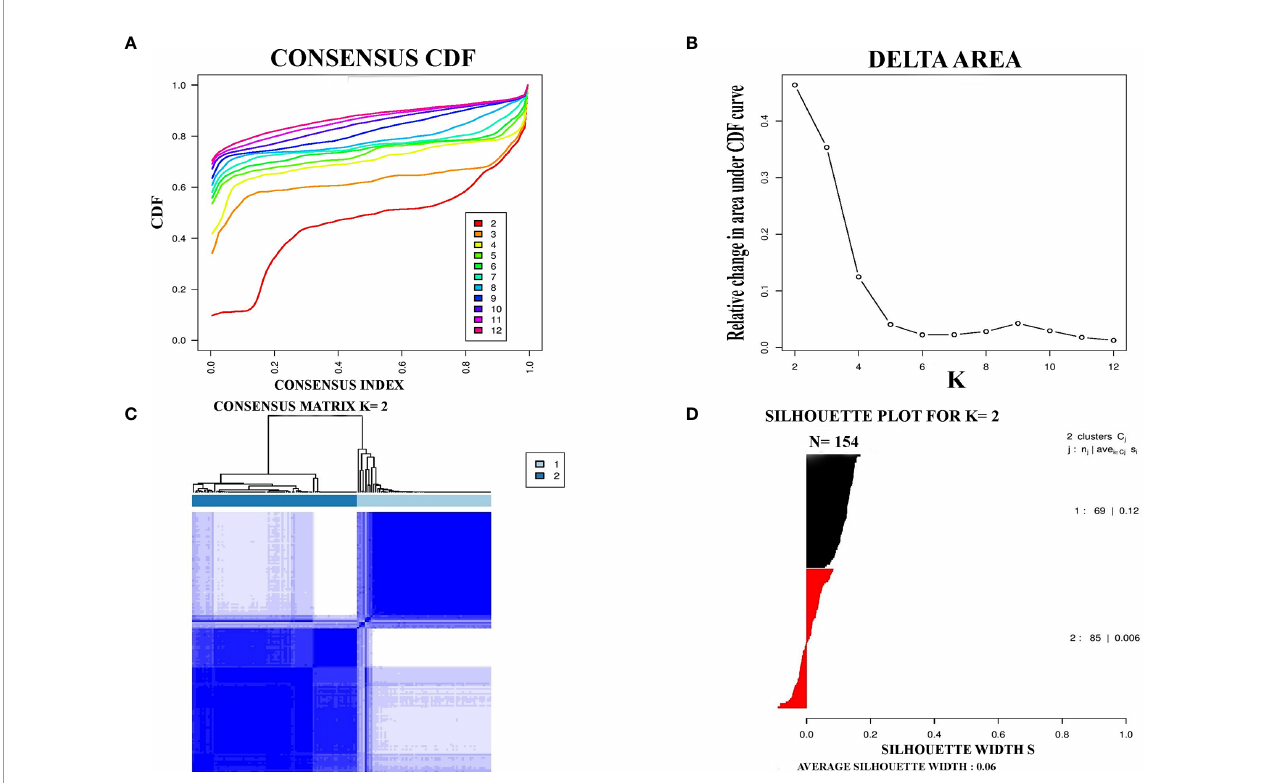
FIGURE 1 | Represented two molecular subtypes in TCGA cohort of PCC. (A) The optimal number of PCC molecular subtypes was determined through Empirical cumulative distribution plot. (B) The increasement of area under the CDF curve with the increased expected number of molecular subtypes. (C) Consensus clustering matrix for the two distinct subtypes of PCC. (D) Silhouette plot based on Consensus clustering